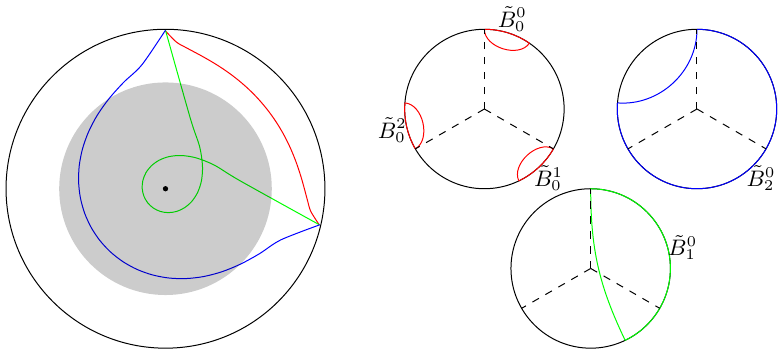
Figure 1 . L.h.s. : constant time slice of the conical defect geometry in AdS 3 for N = 3 (i.e. for the quotient group Z 3 ), together with minimal (in red) and non-minimal geodesics (in blue and green). The entanglement shadow indicated in grey is not penetrated by any minimal geodesic. R.h.s. : some of the corresponding geodesics together with their associated boundary intervals ~ B i on a constant time slice of the covering